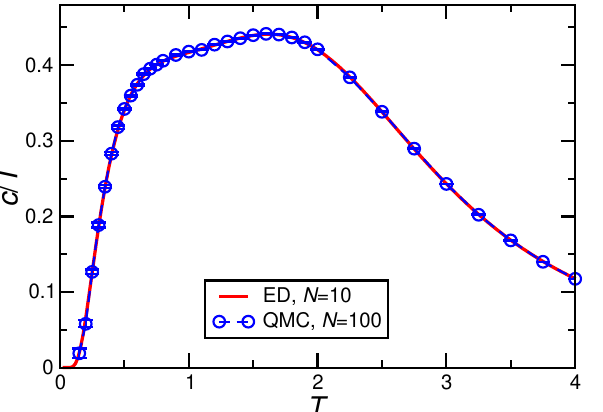
Figure 7. Specific heat per spin divided by temperature c / T calculated for D = 0.36/2.8, J = 1 in a magnetic field h =